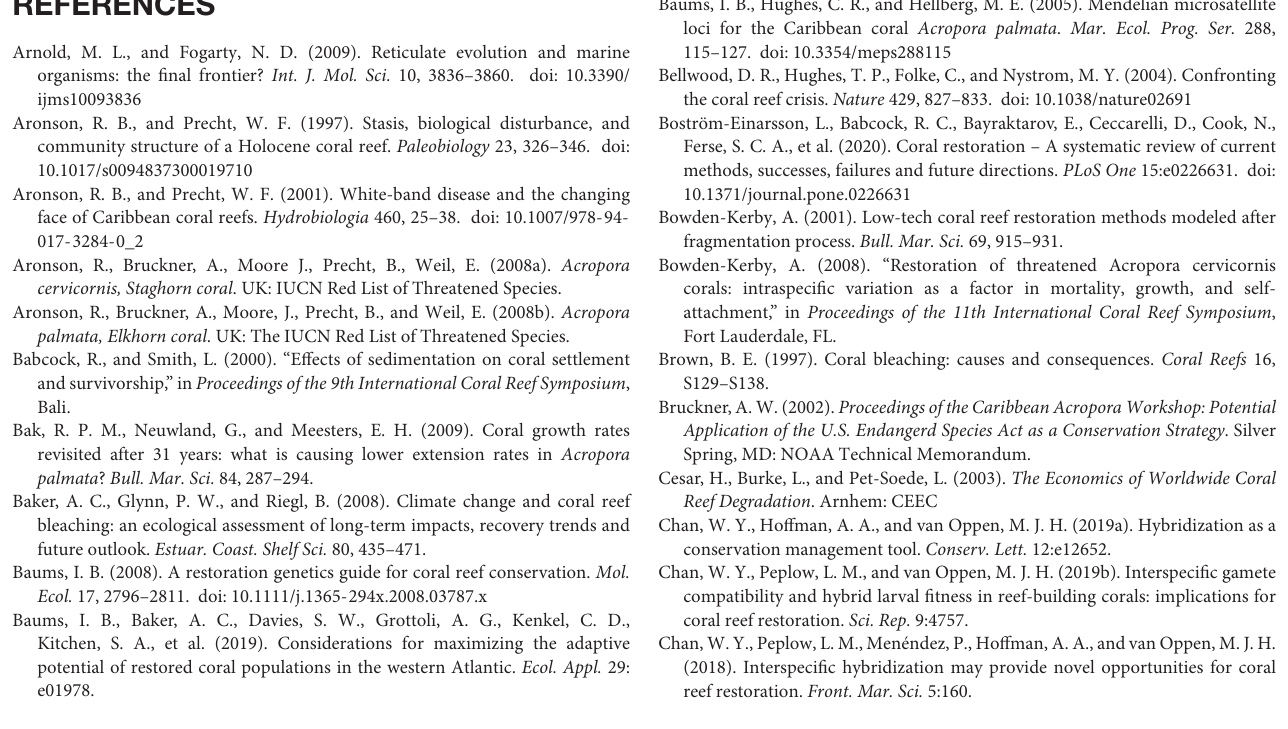
Supplementary Figure 1 | Coral collection locations around New Providence, shown by the yellow points. Inset : New Providence (in box) in relation to Florida and the Berry Islands. Supplementary Figure 2 | Nursery site experimental setup. Coral fragments were placed on the middle three tree branches shown here with a letter and